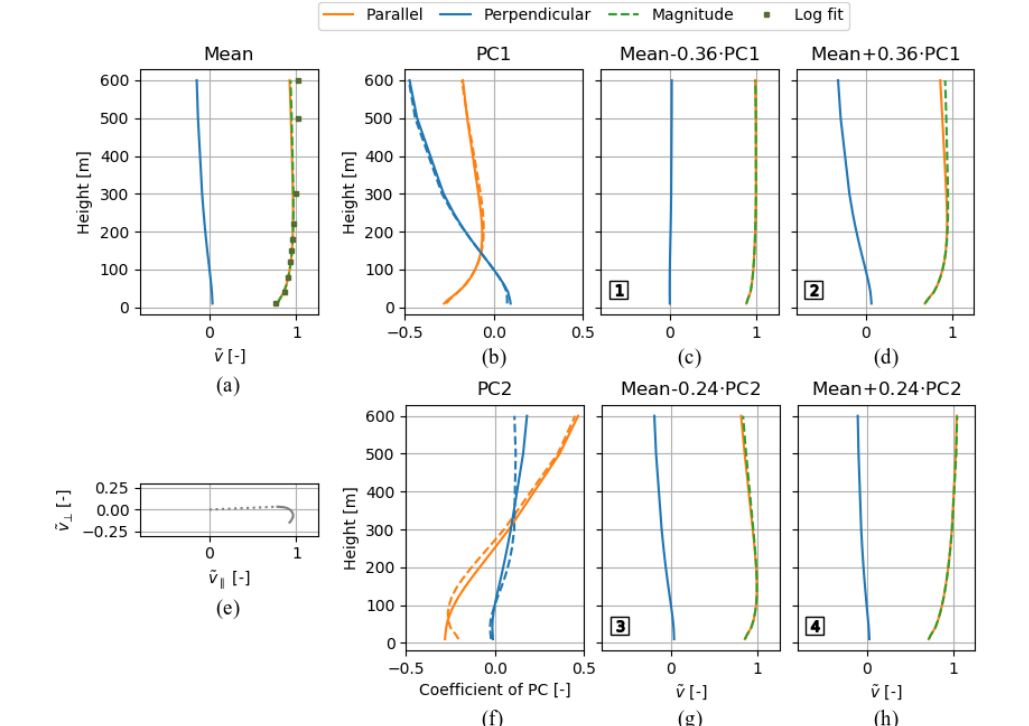
Figure 2. Mean wind profile shape and corresponding non-adiabatic logarithmic profile fit (a) and corresponding hodograph (e) for the filtered offshore dataset. Composition of the first and second PCs (b, f) . The average of the PC1 (PC2) profiles from the two reference locations is plotted alongside the offshore PC1 (PC2) profile using the dashed line. PC multiplicands superimposed on the mean wind profile shape using − 1 (c, g) and + 1 (d, h) standard deviation as multipliers. The wind profile shape numbers 1–4 refer to the markers in Fig. 4a.